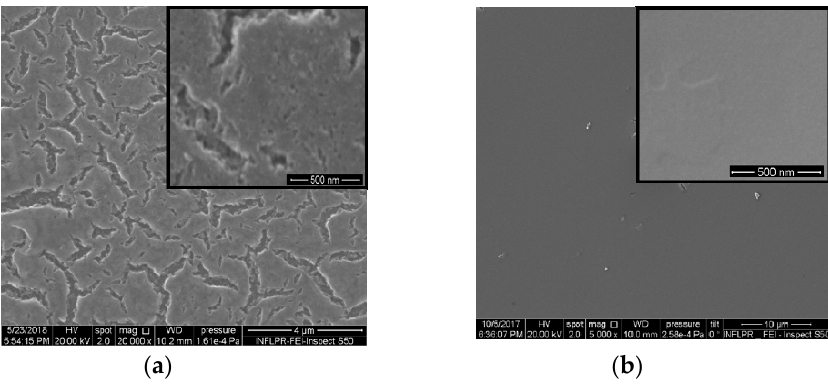
Figure 1. SEM images: ( a ) 1Pt,N-TiO 2M1 film; ( b ) 1Pt,N-TiO 2M2 film.